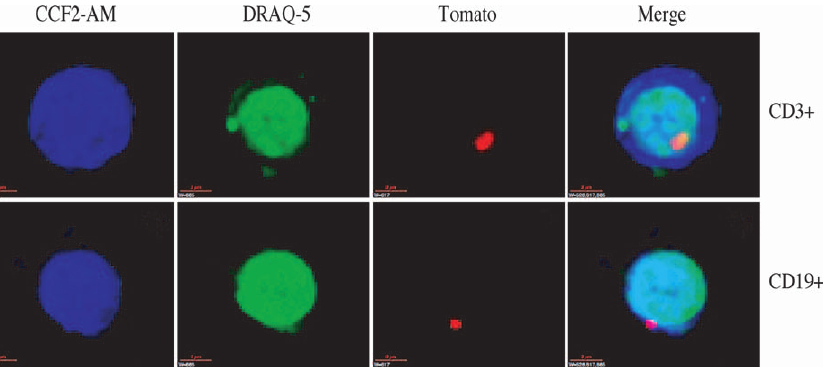
Figure 6. CD3 þ and CD19 þ Cells Contain Salmonella Blue cells that are CD3 þ or CD19 þ were FACS sorted and visualized for the presence of intracellular red-fluorescent Salmonella using fluorescence microscopy. Experiments were performed as described in Figure 5 and red reference bars represent 2 l m.